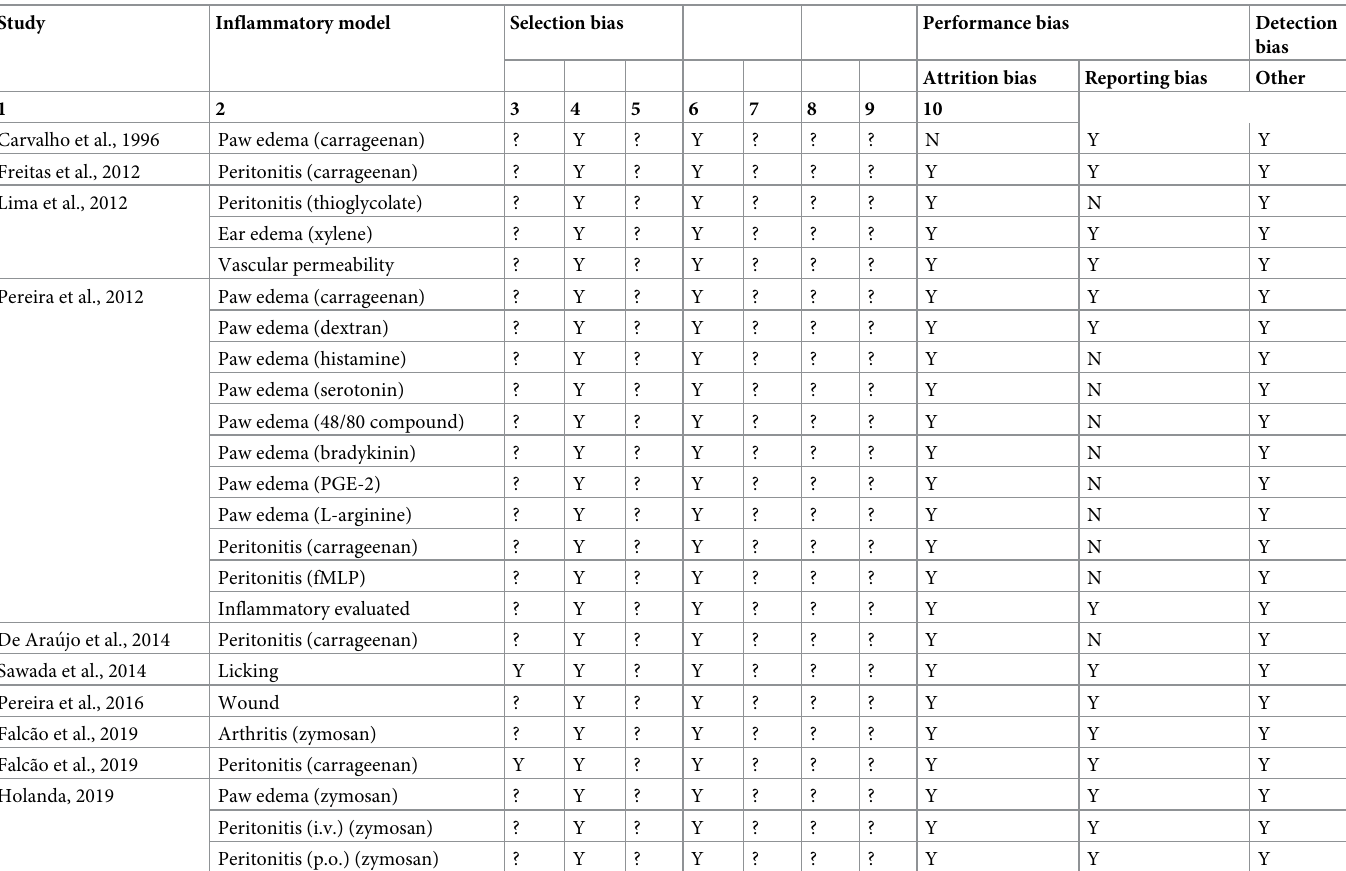
Table 6. Risk of bias in vivo studies according to SYRCLE’s RoB tool of the ten studies included in the systematic review.